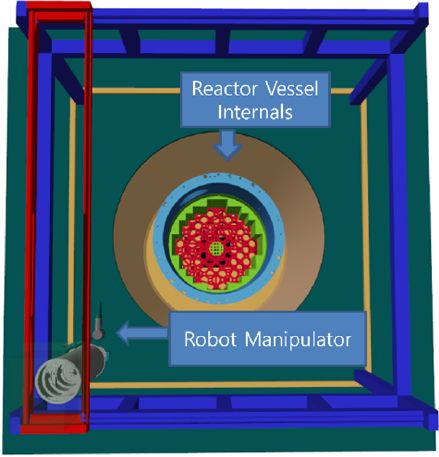
Figure 1. Nuclear powerplant simulator.